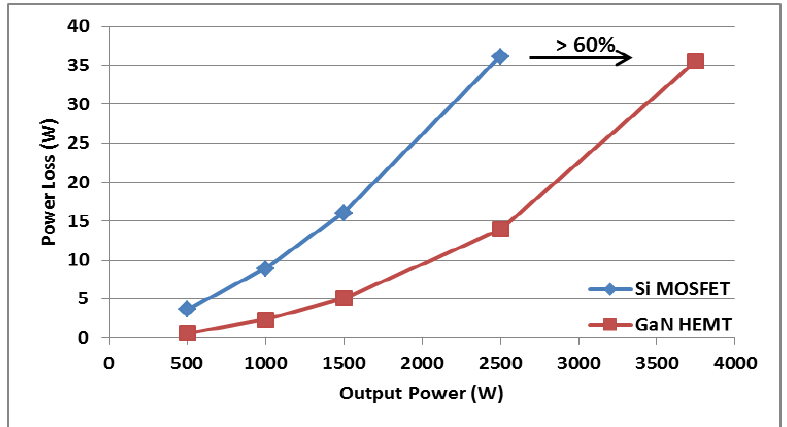
Figure 15. Power rating improvement, output power increase with same power